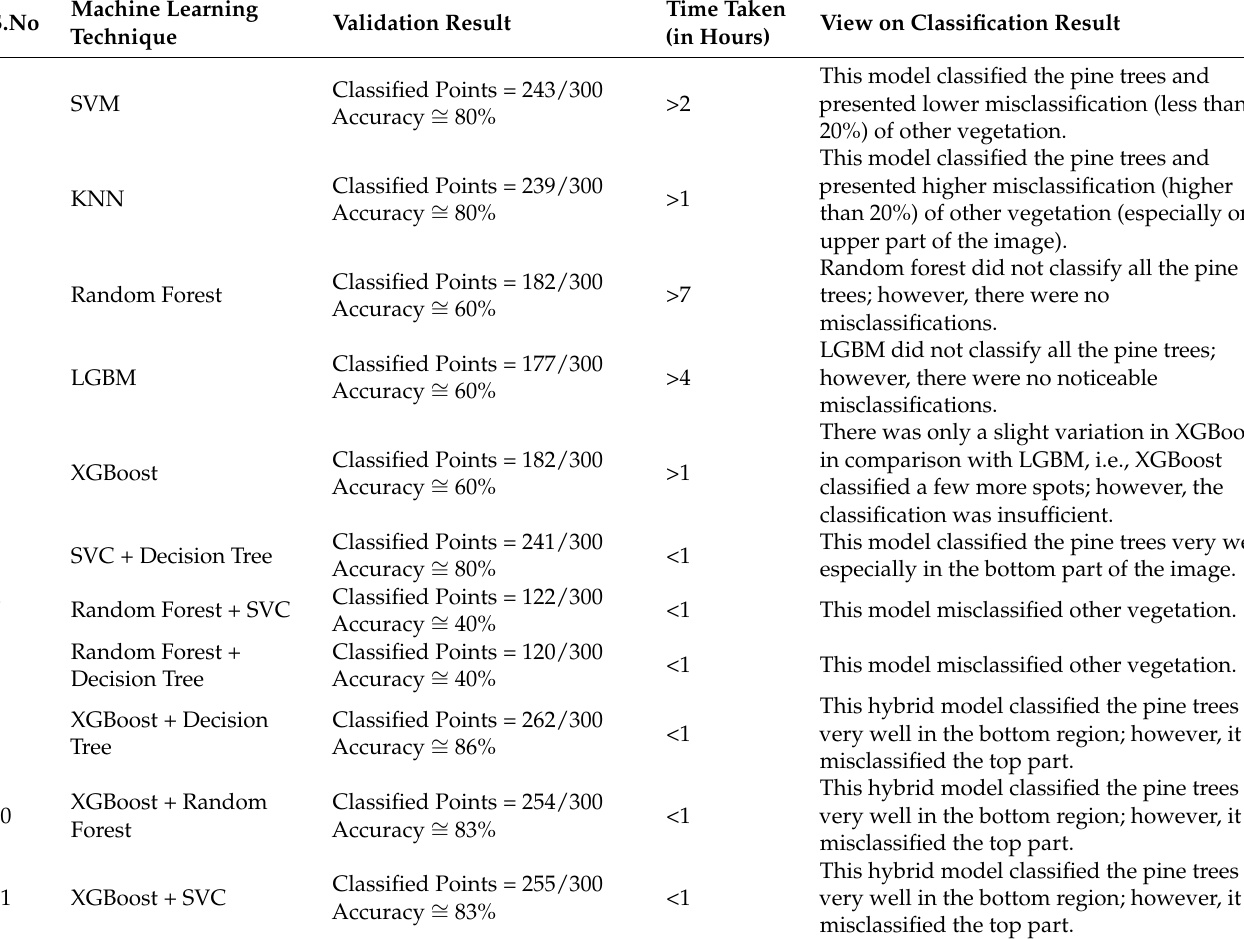
Table 3. Validation Details of the